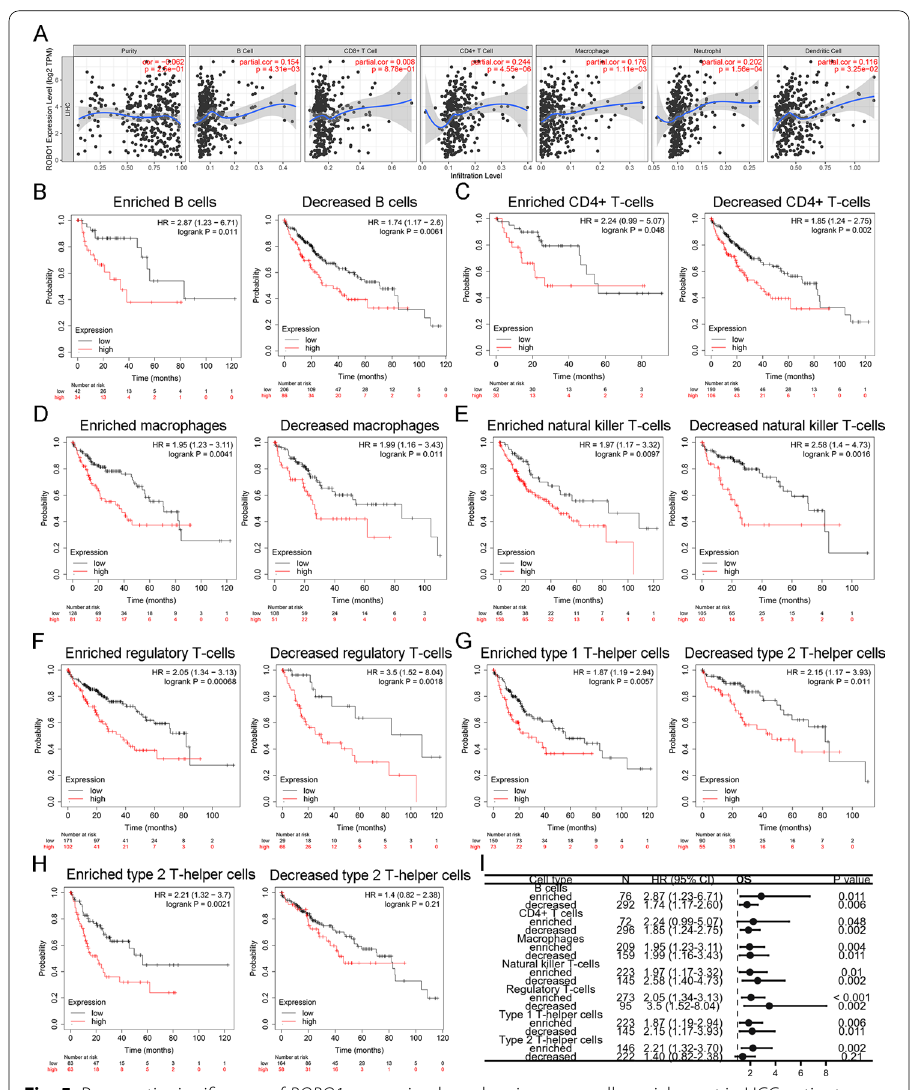
Fig. 5 Prognostic significance of ROBO1 expression based on immune cells enrichment in HCC patients. TIMER database was used to validate the association between ROBO1 expression and immune cell enrichment in HCC ( A ). The association between ROBO1 and OS was analysed in subgroups of enriched and decreased immune cells of B cells ( B ), CD4 + T cells ( C ), macrophages ( D ), natural killer T cells ( E ), regulatory T cells ( F ) and type-1 T-helper cells ( G ) and type-2 T-helper cells ( H ). Univariate Cox regression was used to analyse the association between ROBO1 and OS in enriched and decreased immune cell subgroups ( I